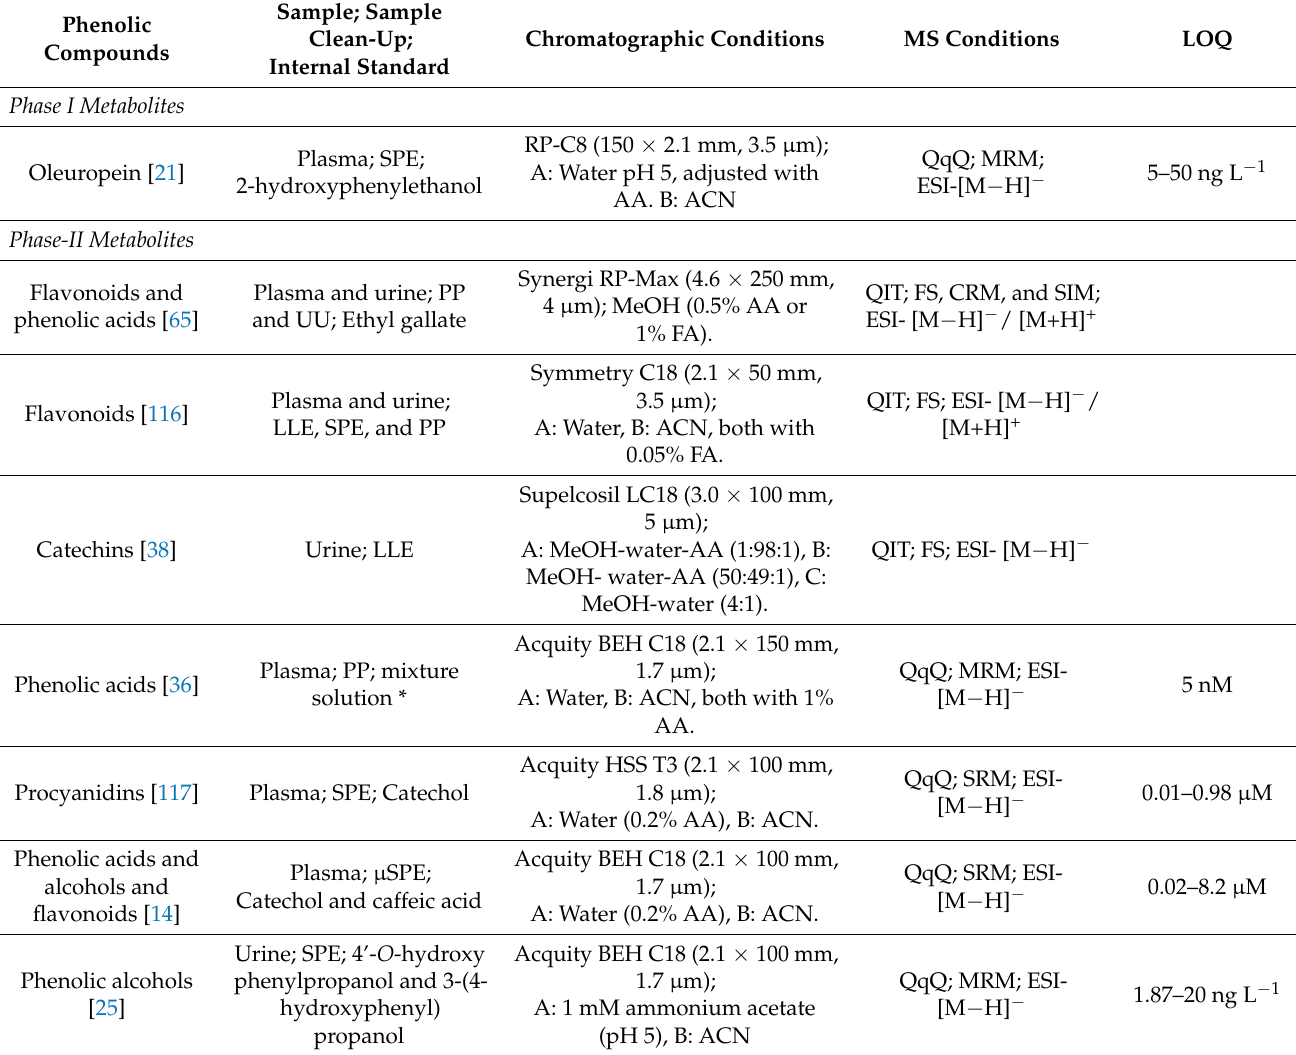
Table 3. Chromatographic and MS conditions for the quantification of PCM in plasma and urine samples. Phenolic Chromatographic Conditions MS Conditions